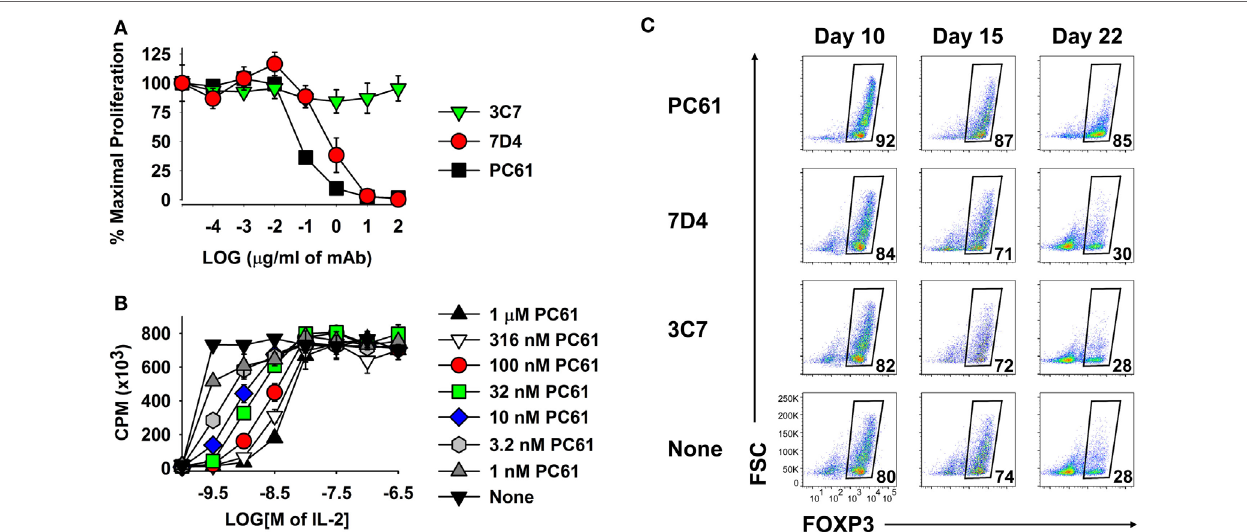
FigUre 5 | The PC61 anti-CD25 monoclonal antibody (mAb) was a functional antagonist of IL-2 growth at low concentrations of IL-2 and was superior to the 7D4 and 3C7 anti-CD25 mAbs for maintenance of regulatory T cells. (a,B) A continuously propagated line of IL-2 dependent CD4 + T cells (SJL-PLP.1 T cells) was used as IL-2 responders in these assays. These T cells (3,000/well) were cultured with rat IL-2 and designated concentrations of PC61, 7D4, or 3C7 mAbs (a) or were cultured with designated concentrations of purified PC61 and mouse IL-2 (B) . Cells were pulsed with [ 3 H]thymidine during the last 24 h of a 3-day culture. (c) 2D2-FIG splenocytes were activated at a density of 2 × 10 6 cells/ml cRPMI with 1 µM MOG35-55 in the presence of 10 nM TGF- β . After 3 days, cells were passaged at a density of 10 6 cells/ml with IL-2 plus 10 µg/ml PC61, 7D4, 3C7, or no anti-CD25 mAb. Cells were passaged every 3–4 days in IL-2 with the same anti-CD25 antibody. V β 11 + T cells were analyzed for FOXP3 expression on days 10, 15, and 22. These experiments are representative of three independent